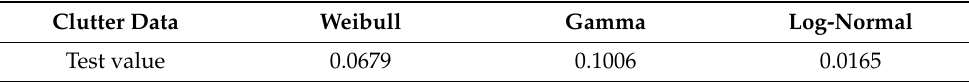
Table 1. Test results of goodness of fit.